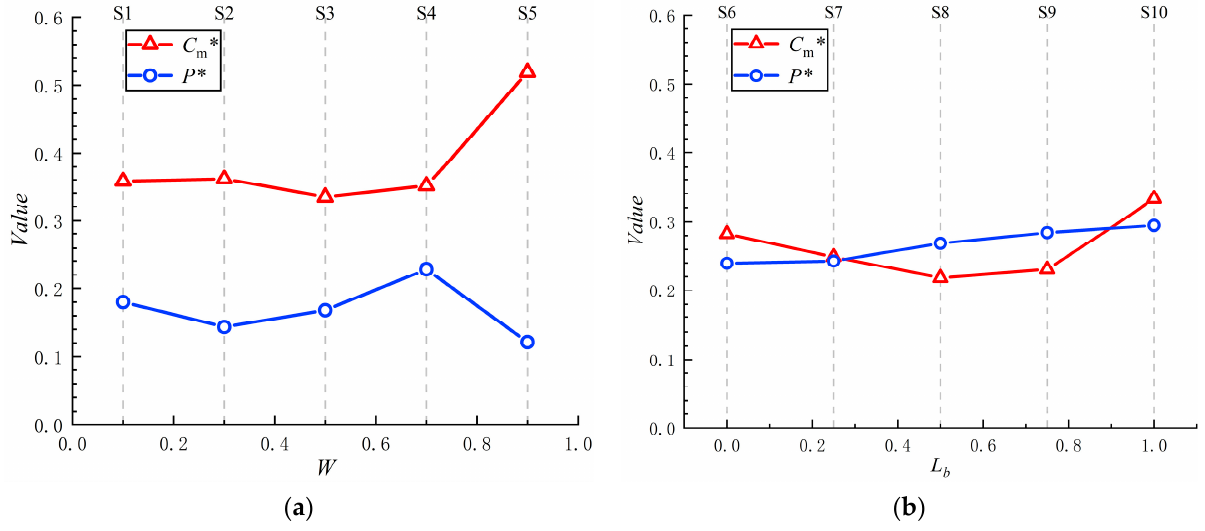
Figure 20. The value of C m * and P* in S1–S10. ( a ) Case S1–S5; ( b ) and Case